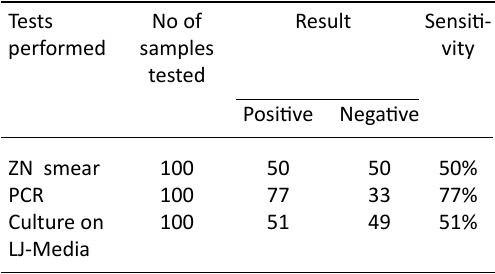
Table 2. Sensitivity of different tests conducted